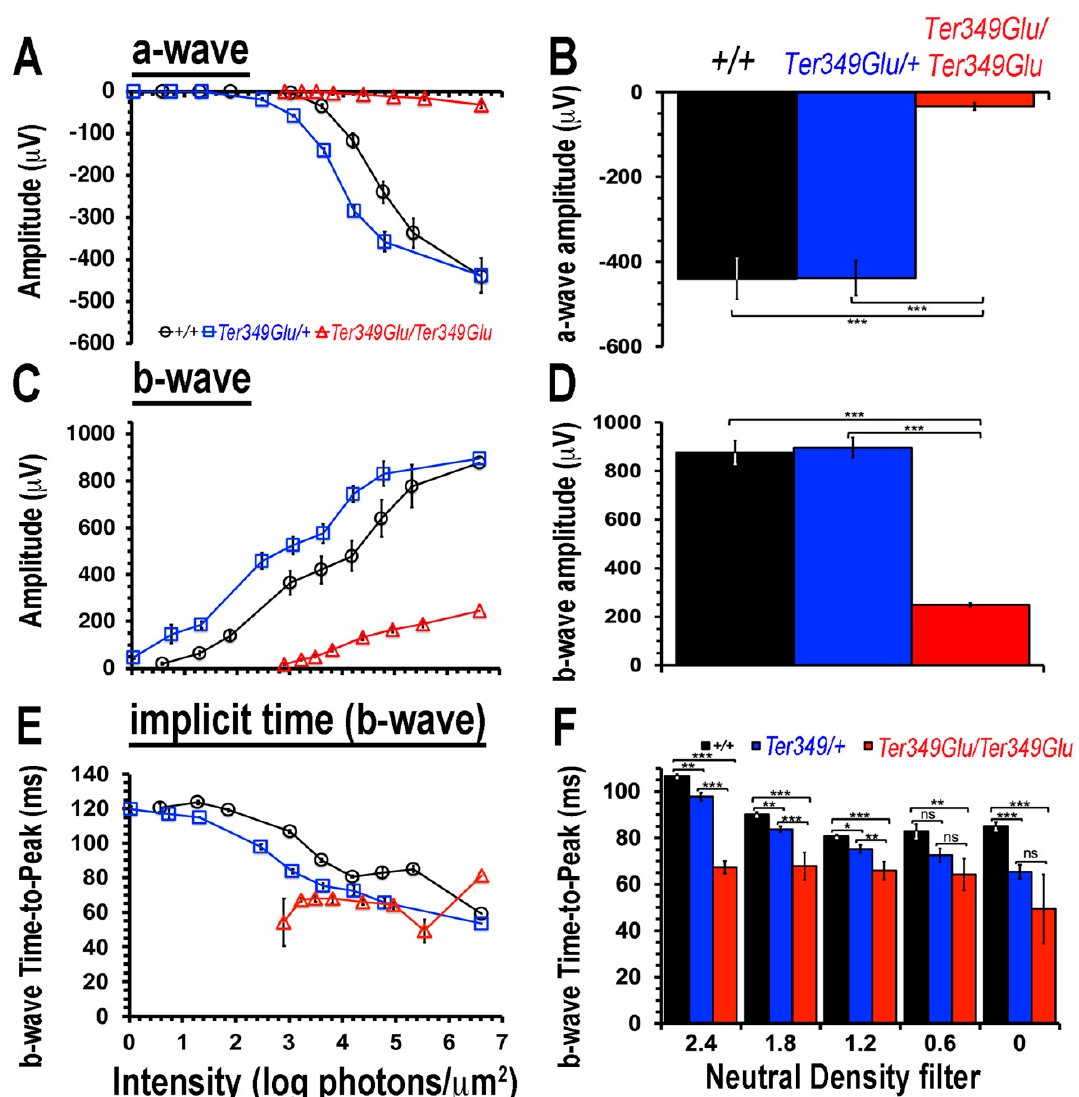
Figure 1. Electroretinogram (ERG) responses decline in mice expressing Ter349Glu rhodopsin. Using ERG to record extracellular potential differences across the retina, the electrophysiological function of +/+, Ter349Glu/+ , and Ter349Glu/Ter349Glu mice was monitored by measuring a-, b-waves, and response latencies (Time-to-Peak, TTP) under increasing stimulus intensities ( A , C , E ). Graphs compare maximum average wave amplitudes and TTP ( B , D , F ) under dark-adapted conditions. Data analyzed using two-tailed T-test and expressed as the mean ± S.E.M. *, p < 0.05; **, p < 0.01; ***, p < 0.001; ns, not significant.